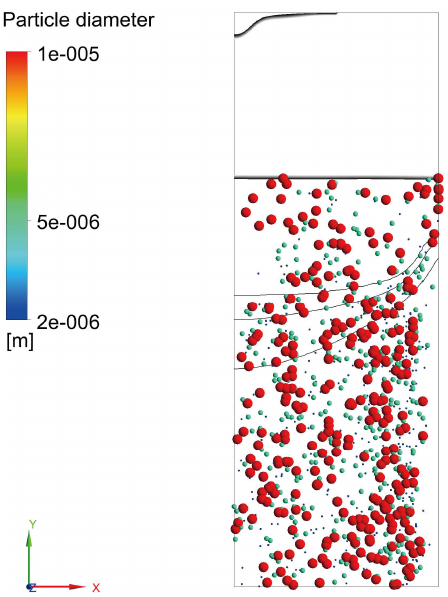
Figure 15. Predicted distribution of inclusions with different diameters. Only one-sixth of the total inclusions are displayed.